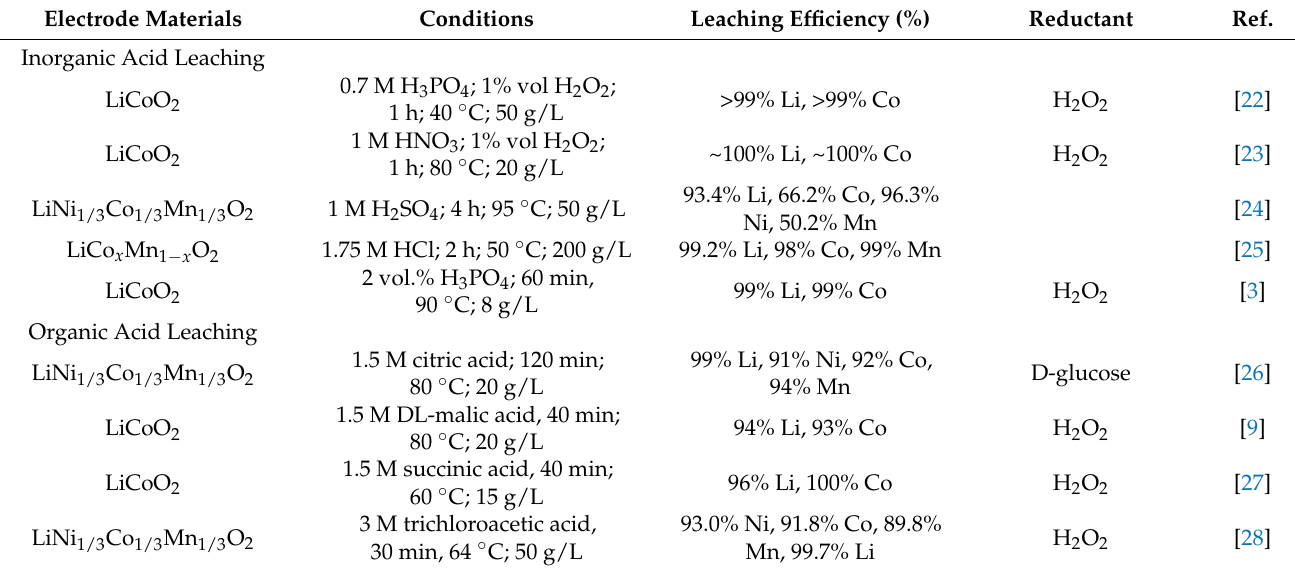
Table 1. Leaching of spent LIBs using different leaching